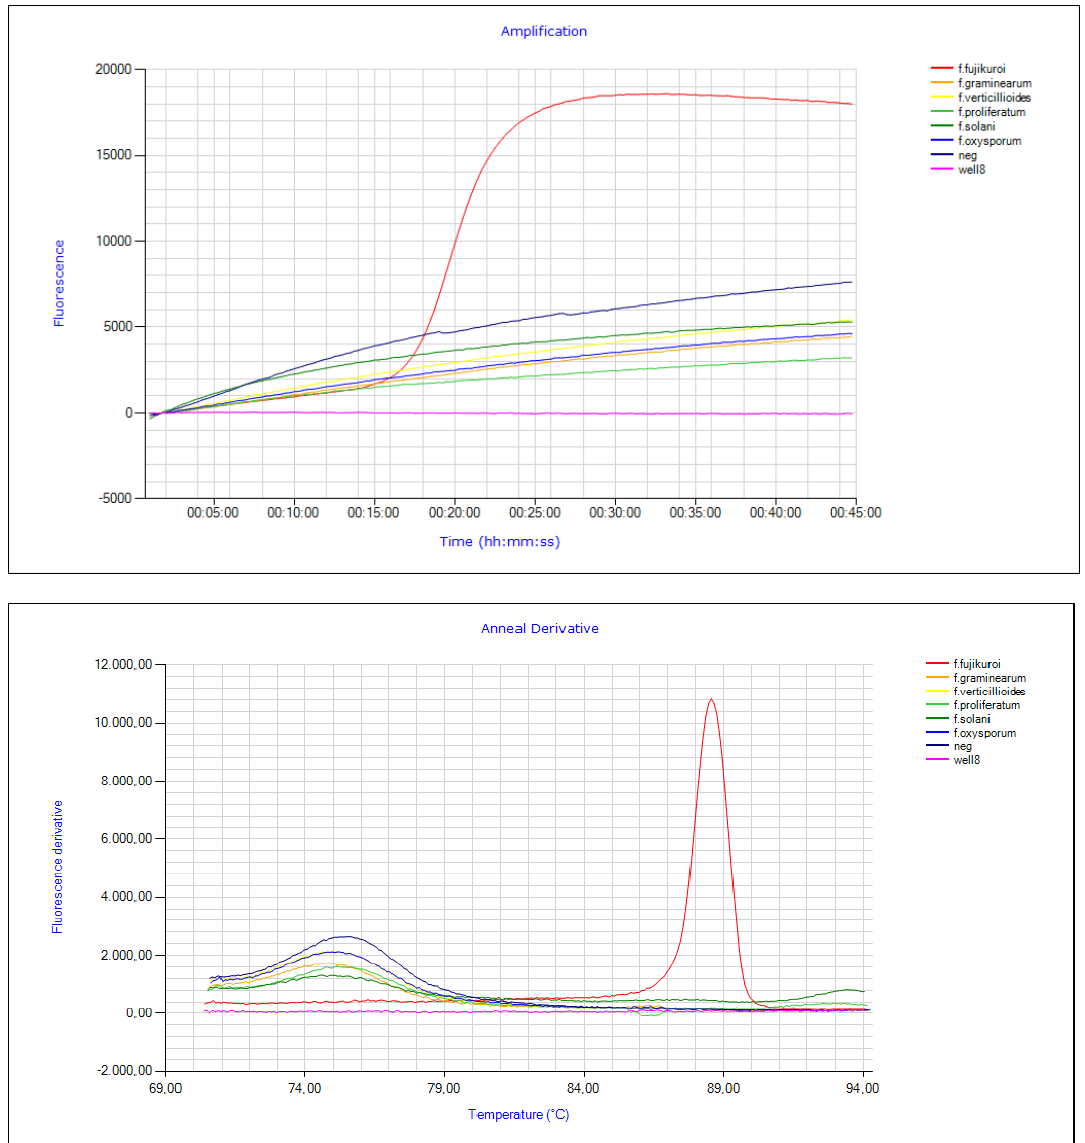
Figure 5. Validation of the analytical specificity of the LAMP reaction obtained with amplification of F. fujikuroi DNA (I1.3) compared to five other isolates of Fusarium belonging to the GFSC, F. proliferatum and F. verticillioides , and F. graminearum, F.